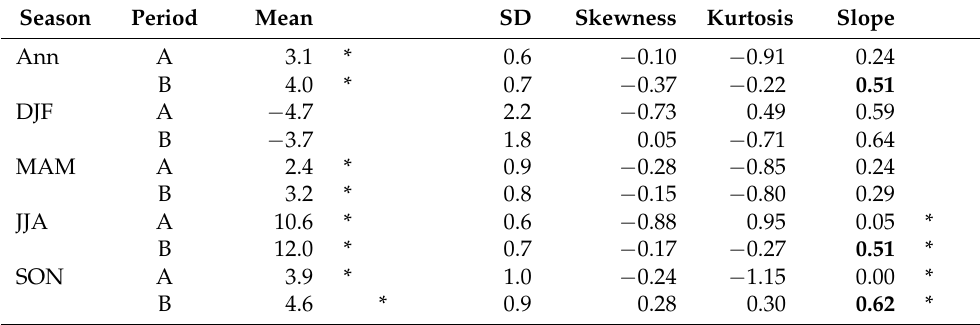
Table 5. Selected statistical characteristics of annual (Ann) and seasonal (DJF, MAM, JJA, and SON) mean minimum temperature series in the Czech Republic in the 1961–1990 (A) and 1991–2020 (B) periods: means and standard deviations (SD) are in ◦ C, linear trends in ◦ C/10 years (in bold statistically significant at the 0.05 significance level). An asterisk * indicates statistically significant differences of a given characteristic between two 30-year periods.